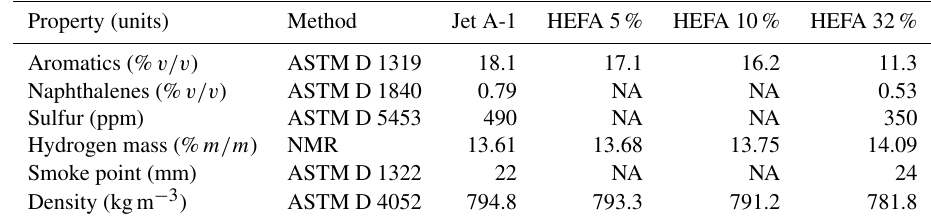
Table 1. Fuel specifications overview (NA: measurement not available). Property